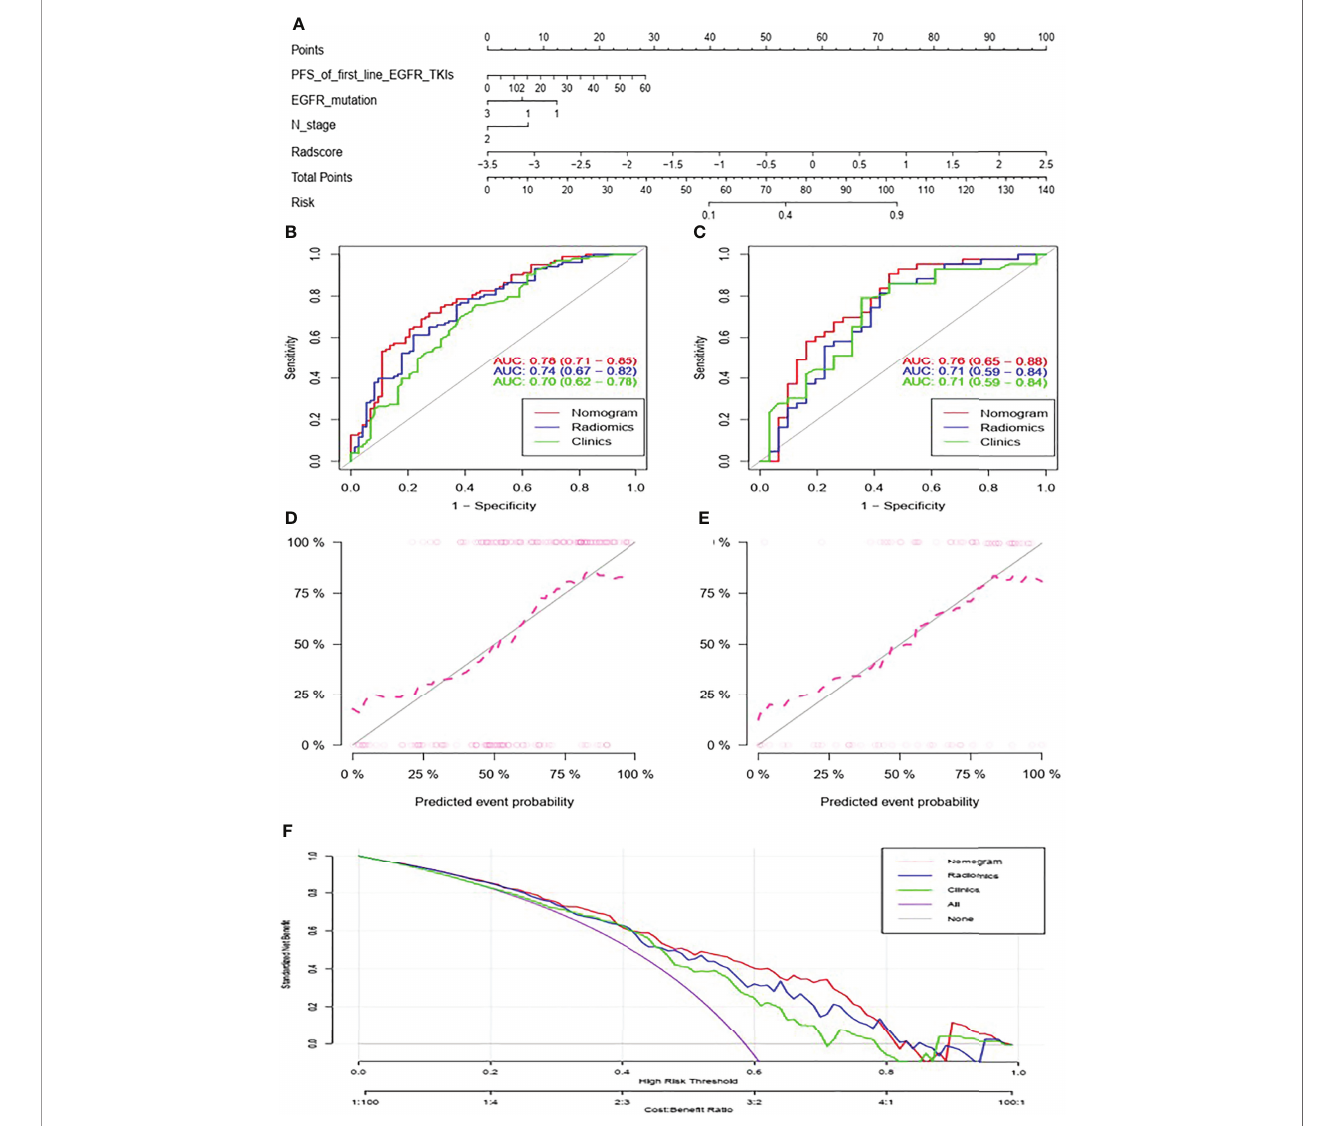
FIGURE 2 | Nomogram for predicting acquired T790M mutation in advanced lung adenocarcinoma patients after progression on fi rst- or second- generation EGFR TKIs (A) . ROC curves of the clinical, radiomics, and nomogram models in the training set (B) and in the validation set (C) . Calibration curve of the nomogram in the training set (D) and in the validation set (E) . Decision curve analysis of clinical, radiomics, and nomogram models (F)